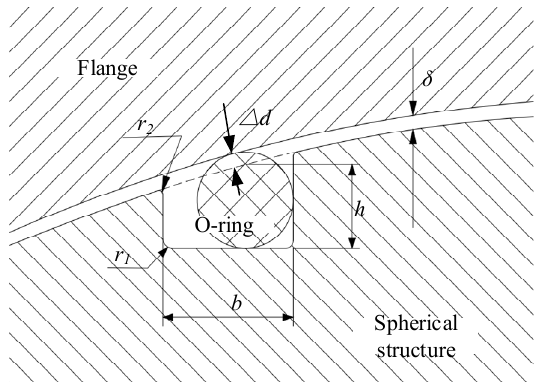
Figure 16. Schematic diagram of compression ratio calculation.